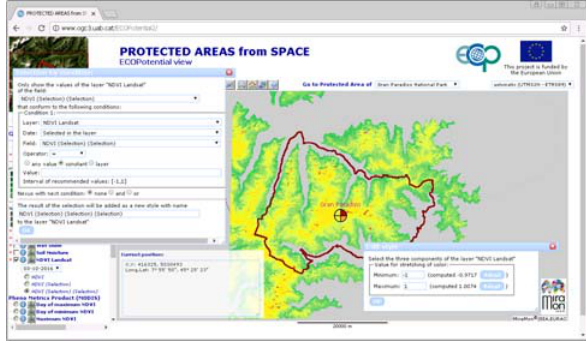
Figure 5. A filter of the NDVI that has a DEM value higher than 2000 m for the Gran Paradiso Natural Park